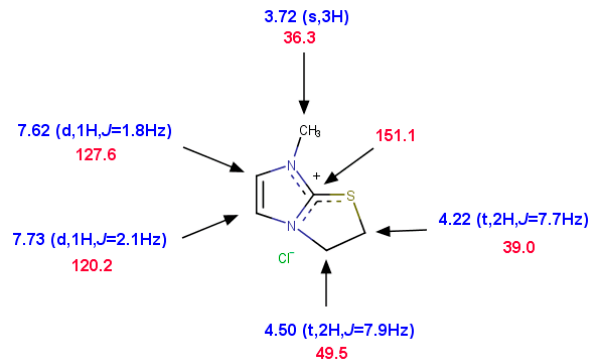
Figure 2. 1 H (600 MHz) (blue), 13 C (151 MHz) (red) NMR chemical shifts in ppm for 4a in DMSO- d 6 at 25 °C.